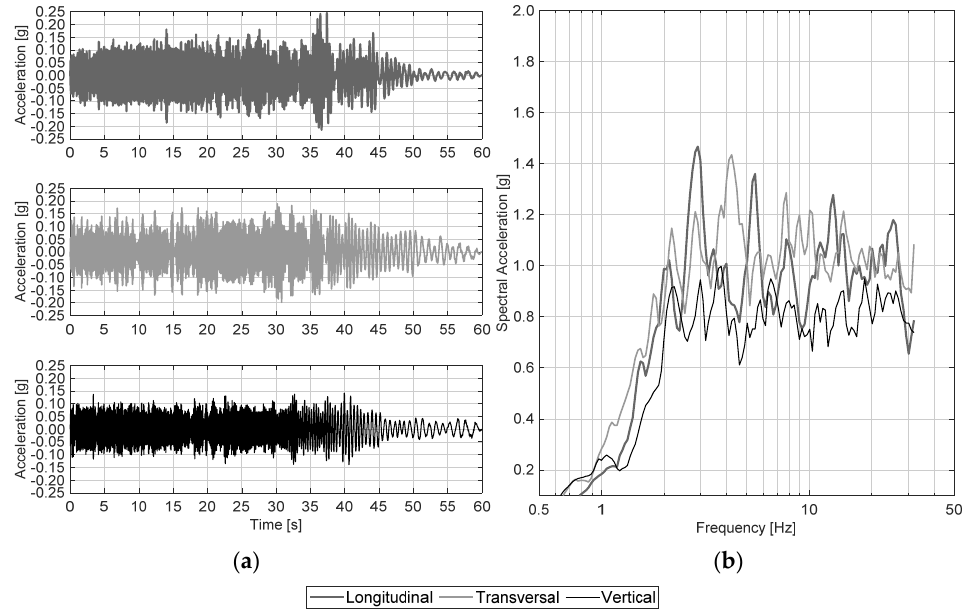
Figure 11. Recommended shake table motions according to FEMA 461: ( a ) horizontal (longitudinal and transversal) and vertical input motions and ( b ) acceleration response spectra, 5% damped.